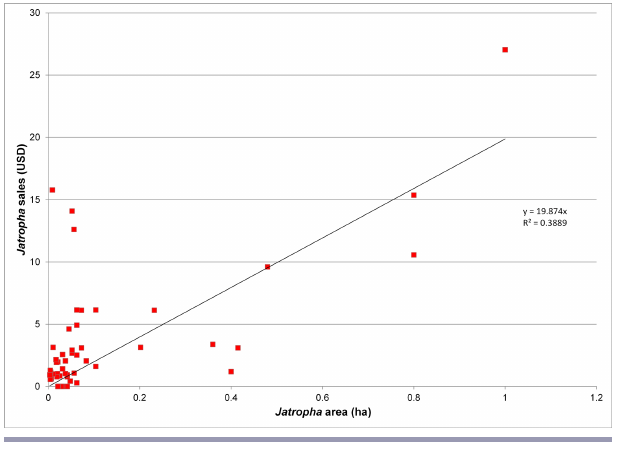
Fig. 4 . Jatropha contributions to total farm income versus area under Jatropha comparing actual tree yields with modeled data for an average Jatropha yield of 0.4 kg